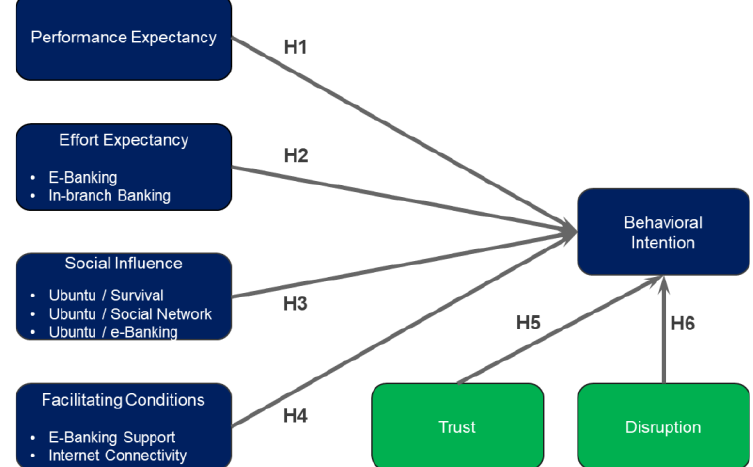
Figure 2: Modified Unified Theory of Acceptance and Use of Technology (UTAUT) for e-banking user behavior in the CMA; Source: Researchers’ own compilation